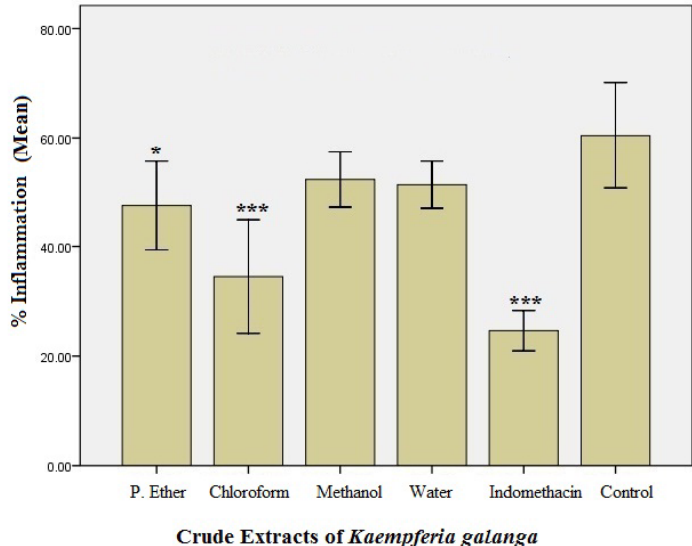
Figure 1. Percentage (%) inflammation observed in crude extract-treated rats after 3rd h of carrageenan administration (n = 6).